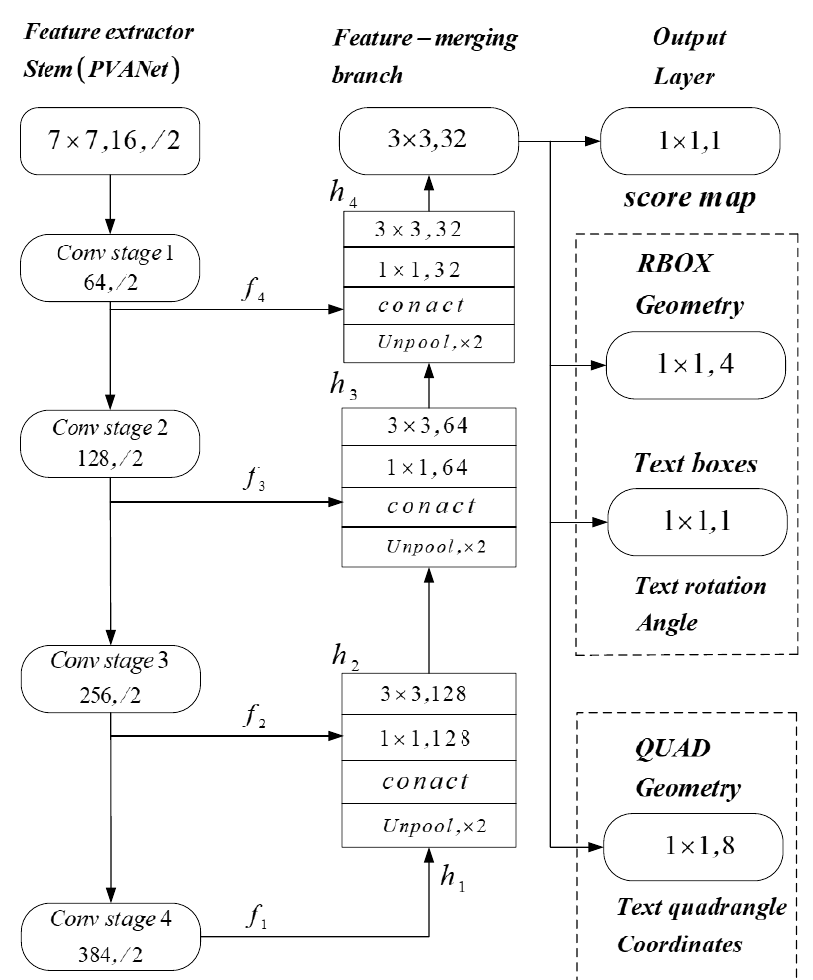
Figure A1. School diagram of FCN network construction.